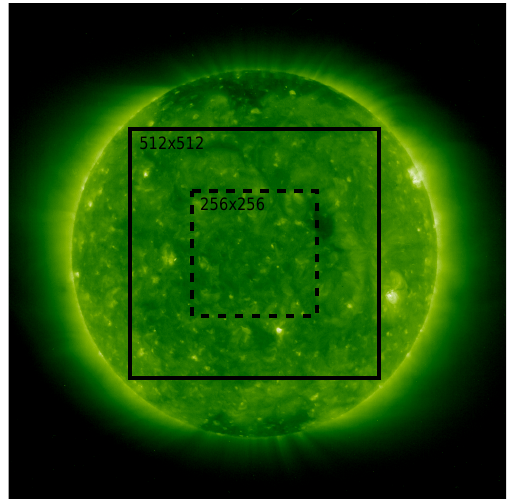
Fig. 1. Example of a Quiet Sun images seen by EIT in 19.5nm, with indication of the squared area taken into account. The mul- tifractal analysis characterizes the region within the square of size 256 ×